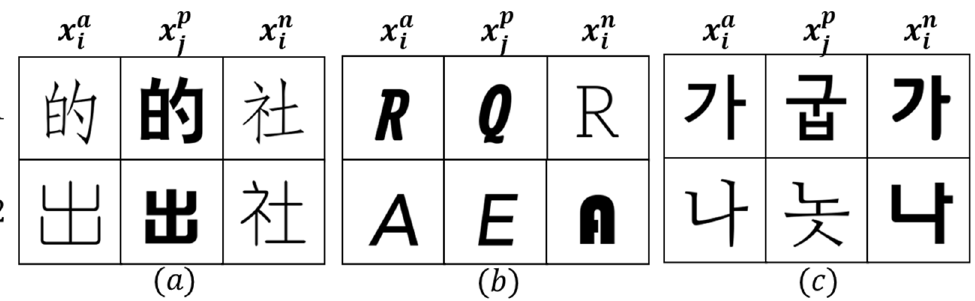
Figure 3. Example of triplet data loader for (a) Chinese, (b) English, and (c) Korean font styles. 𝒙 𝒊 𝒂 , 𝒙 𝒋𝒑 , and 𝒙 𝒊𝒏 represents anchor, positive, and negative images, respectively.